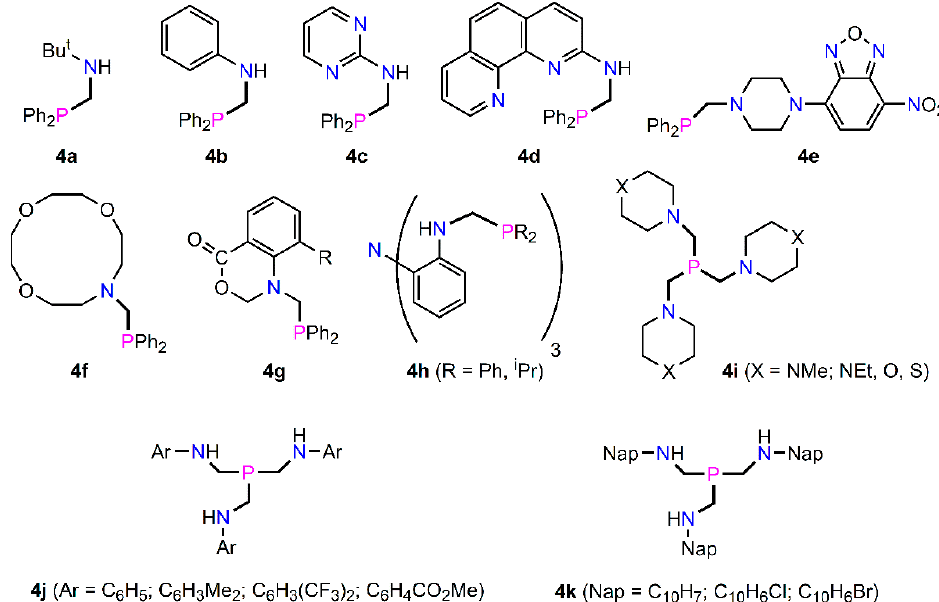
Figure 6. Selected examples of aminomethylphosphines bearing one or more P–C–N